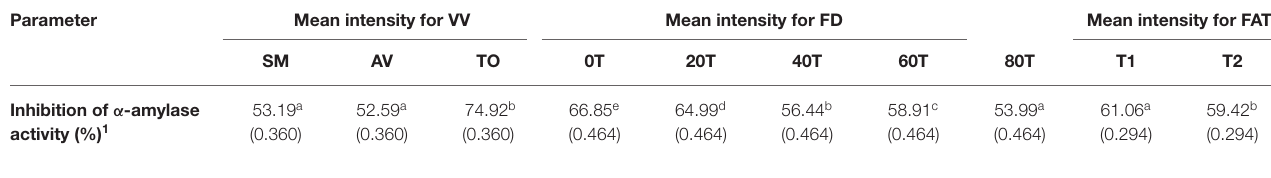
TABLE 1 | Results from 3-way ANOVA and Duncan’s test of the effects of vegetable variety, (VV); fertilizer dose, (FD); fertilizer application time, (FAT): T1 at planting, T2 after planting; Telfairia occidentalis, TO; Solanum marcrocarpon, SM; Amaranthus viridis, AV; (0T-80T as fertilizer dosing treatments) on α -amylase inhibitory activity of vegetable leaf aqueous